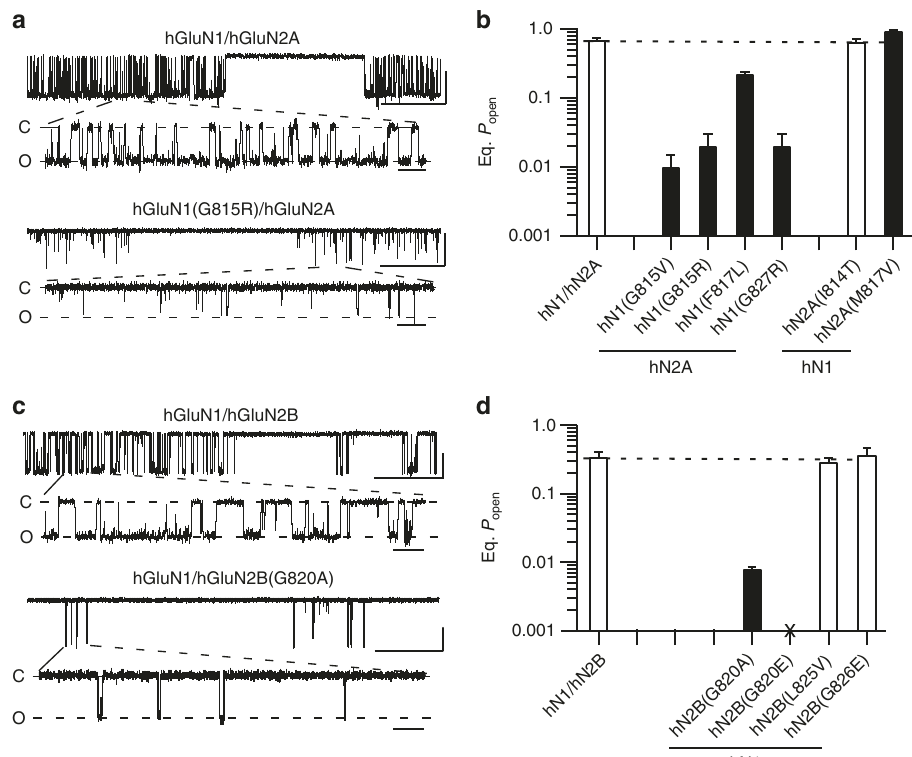
Fig. 3 Single channel recordings of missense mutations in M4 segments. a , c Example single channel recordings of hGluN1/hGluN2A ( a ) or hGluN1/ hGluN2B ( c ) or the same receptor containing missense mutations at the conserved glycine. Recordings were performed in the on-cell con fi guration (holding potential, + 100 mV). Downward de fl ections are inward currents. For each construct, the top half shows a low-resolution ( fi ltered at 1 kHz) and the bottom half a higher resolution portion of same record (3 kHz). Scale bars: 5 pAs for all; time base is 500 ms (upper trace for each construct) and 20 ms (lower trace for each construct). b , d Equilibrium open probability (eq. P open ) (mean ± SEM) ( n > 4 patches) for hGluN1/hGluN2A ( b ) or hGluN1/hGluN2B ( d ) (Supplementary Table 3). Solid bars indicate values signi fi cantly different from wild type ( p < 0.05, t -test). For GluN1/GluN2B(G820E), we could not detect glutamate-activated current either in on-cell patches or whole-cell